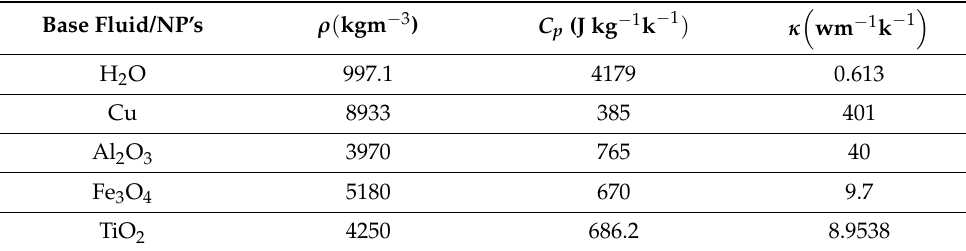
Table 2. Properties of base fluids and NPs